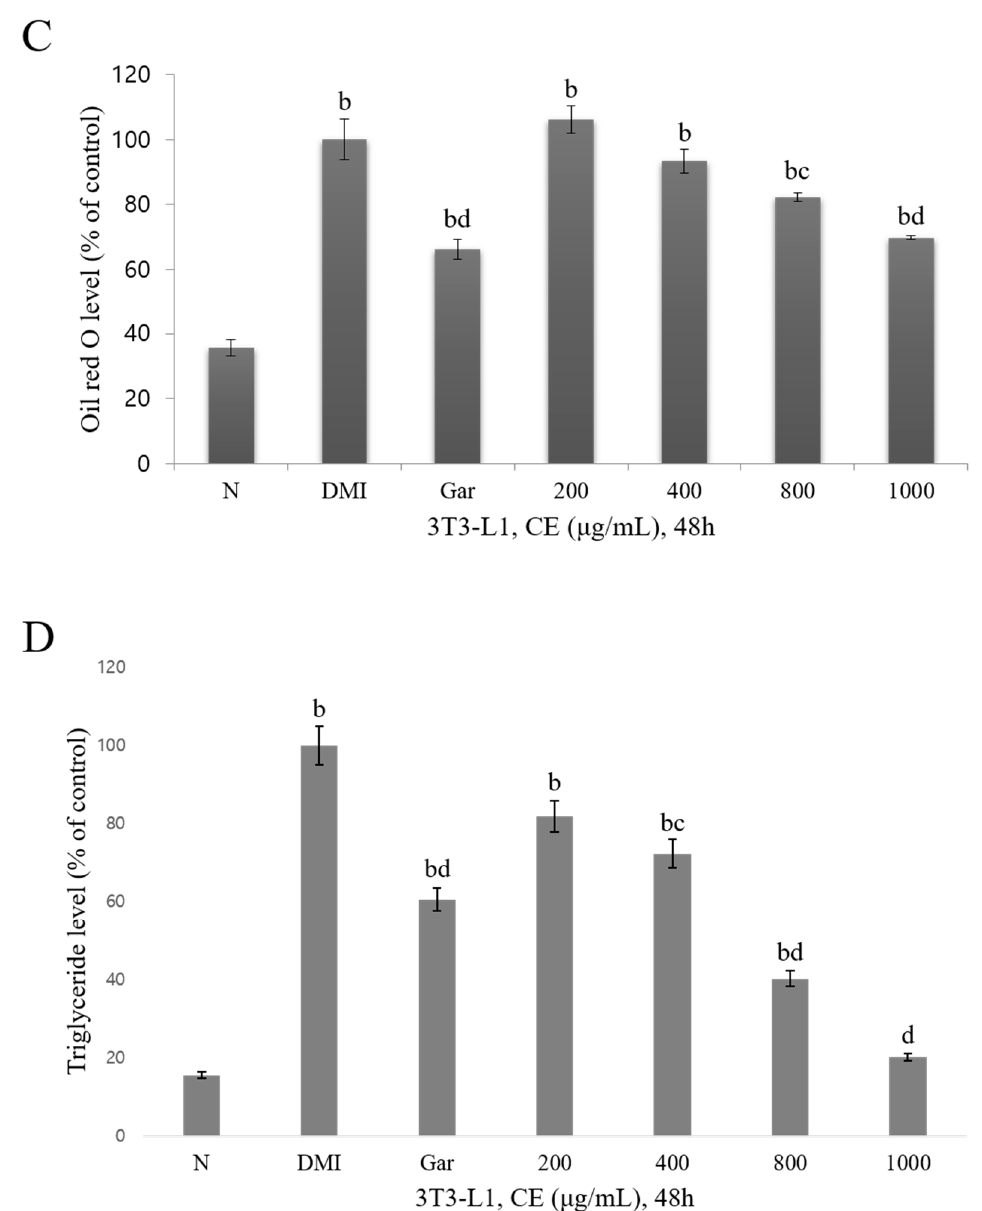
Figure 2. ( A ) The e ff ect of an ethanol extract of Cheongchunchal (CE; 200, 400, 800, and 1000 µ g / mL) and Garcinia (Gar; 200 µ g / mL) on the cell viability of 3T3-L1 preadipocytes. Cell viability was measured by the WST-1 assay. ( B ) The number and size of di ff erentiated adipocytes were observed with an optical microscope at × 100 (Axiovert 100, Germany). ( C ) Lipid levels (Oil Red O levels) were measured by a spectrophotometer at 450 nm. ( D ) Inhibitory e ff ects of CE on the intracellular triglyceride in 3T3-L1 preadipocytes. The statistical analysis was carried out by the use of a t -test. b p < 0.01 compared with group not treated with any substance (N group). c p < 0.05 and d p < 0.01 compared with the 1 µ M dexamethasone, 0.5 mM 3-isobutyl-1-methylxanthine, and 1 µ g / mL insulin treated group (DMI group). The error bars represent the standard error.